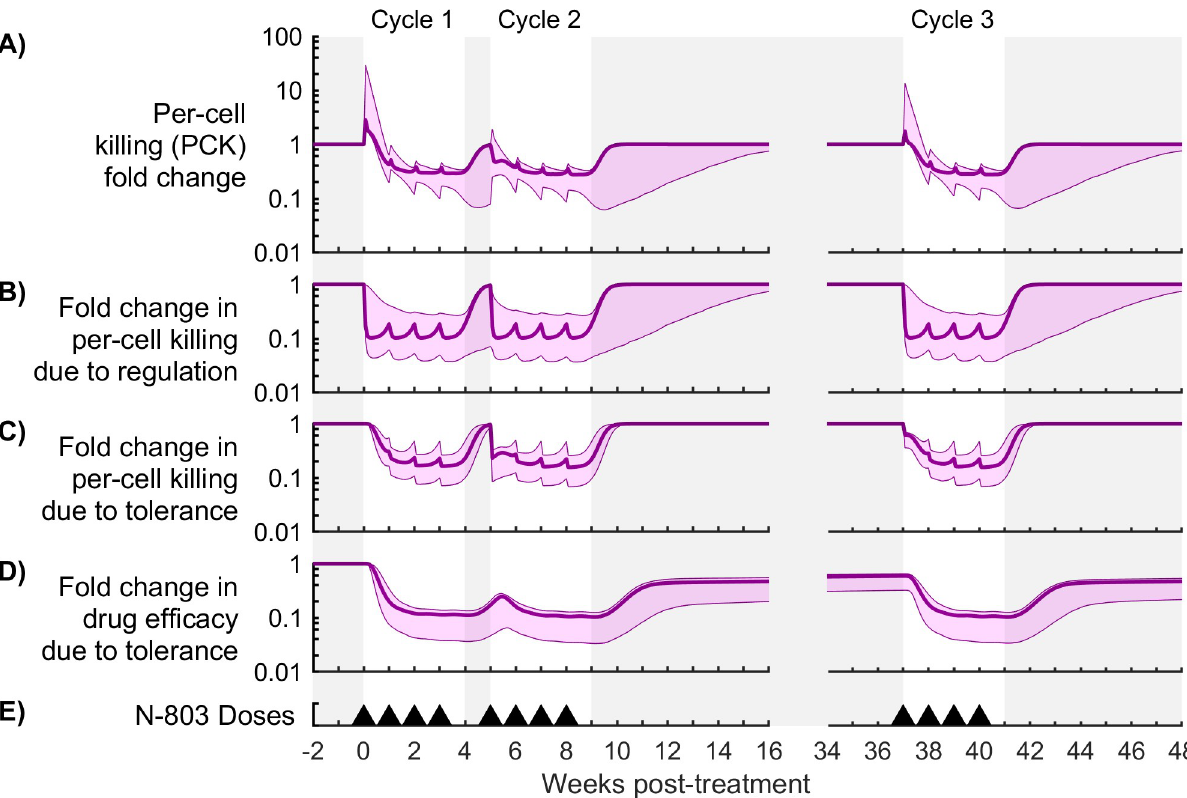
Fig 7. Contributions of immune regulation and drug tolerance to per-cell killing (PCK) for Model #3. Shown are measures of mechanism contribution for the model with immune regulation and drug tolerance (model #3). Panel (A) shows the fold change in per-cell killing rate, or PCK (Eqs 22–24). Panels (B,C) show the effect of immune regulation and drug tolerance on PCK (Eqs 25 and 26). Panel (D) shows the effect of tolerance on drug efficacy (Eq 24). The bold line corresponds to the best-fit model, and the shaded region corresponds to the Bayesian 95% credible interval. Panel (E) shows timing of 0.1 mg/kg subcutaneous doses of